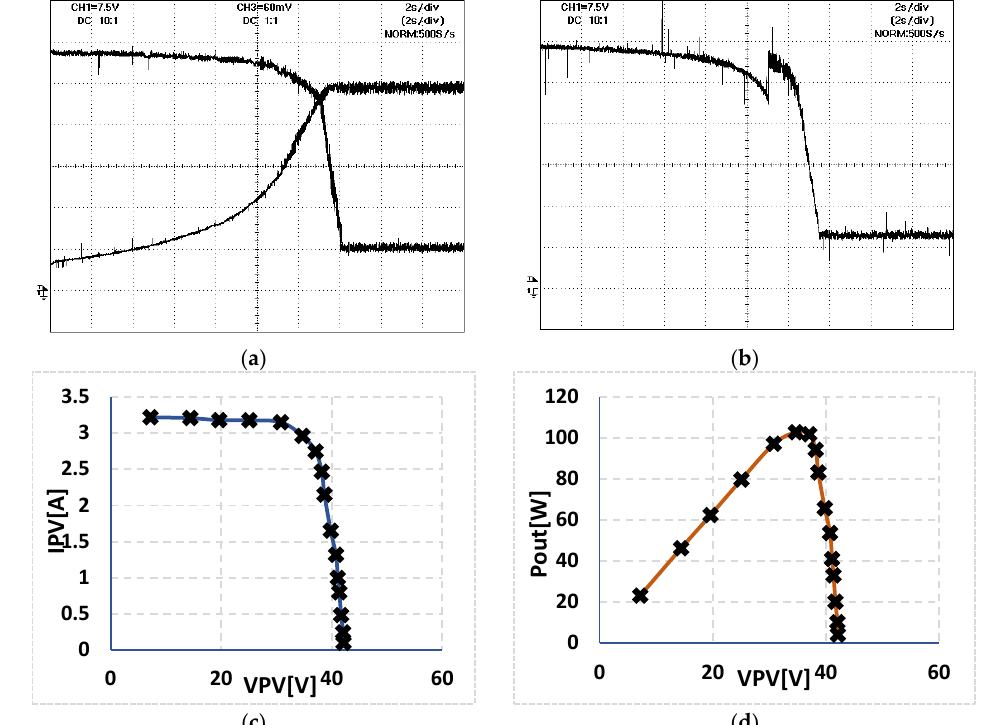
Figure 14. Experimental result in test panel mode (mode I): ( a ) output voltage (Ch1 – 7.5 V/div) and output current (Ch3 – 0.6 A/div) during a continuous load variation; ( b ) Similar to ( a ) considering a step solar irradiation from G = 600 W/m 2 to G = 1000 W/m 2 both at T = 25 °C; ( c ) average data points recorded by the SCADA software for the I-V characteristic curves, at G = 1000 W/m 2 and T = 25 °C; ( d ) Similar to ( c ) applied to P-V characteristic curves.